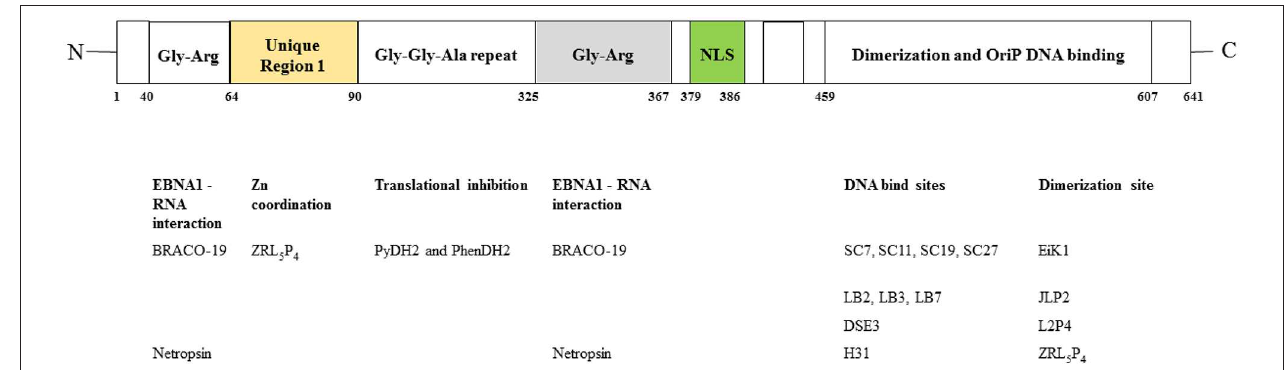
FIGURE 1 | Functional regions in EBNA1. (Upper) Domains of EBNA1. NLS, nuclear localization sequence. (Lower) Agents reported to inhibit these domains. Refer to text for